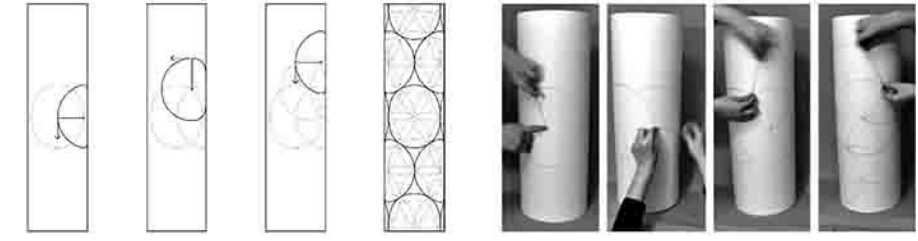
Figure 7: Method of drawing the patterns on a cylinder using a compass